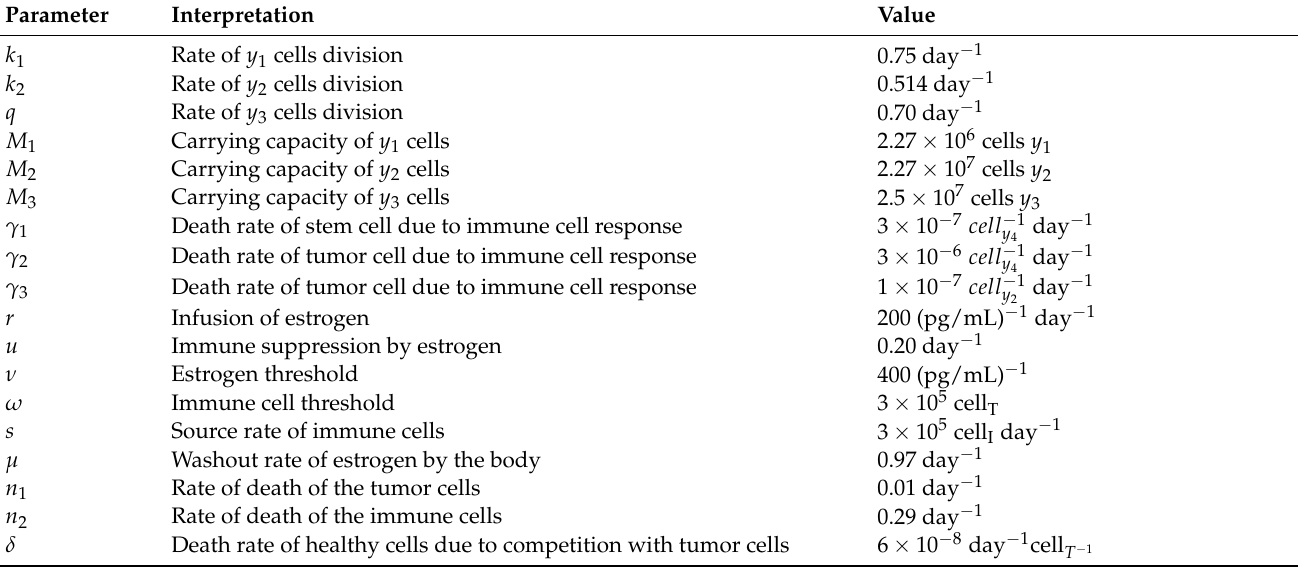
Table 3. Parameter values in different models of drug